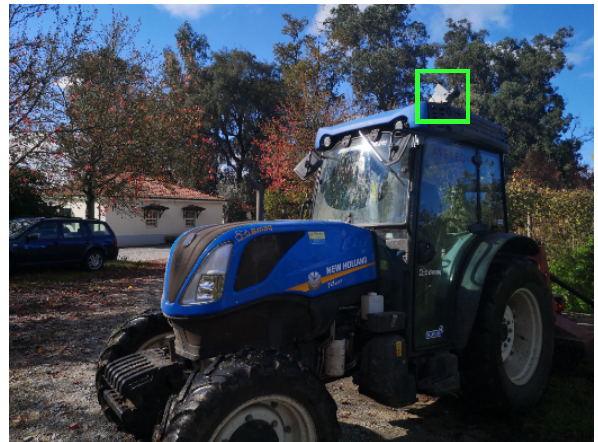
Figure 3. Tractor with the hardware module mounted on top (inside the green